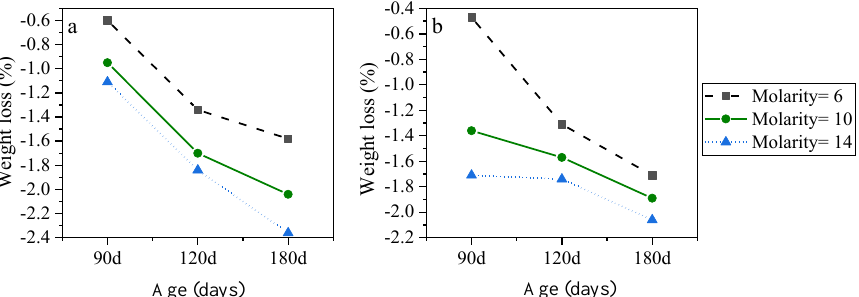
Figure 7. The effects of NaOH molarity on weight loss of AASC with ( a ) NO/NS = 1 and ( b ) NO/NS = 3 after acid exposure.